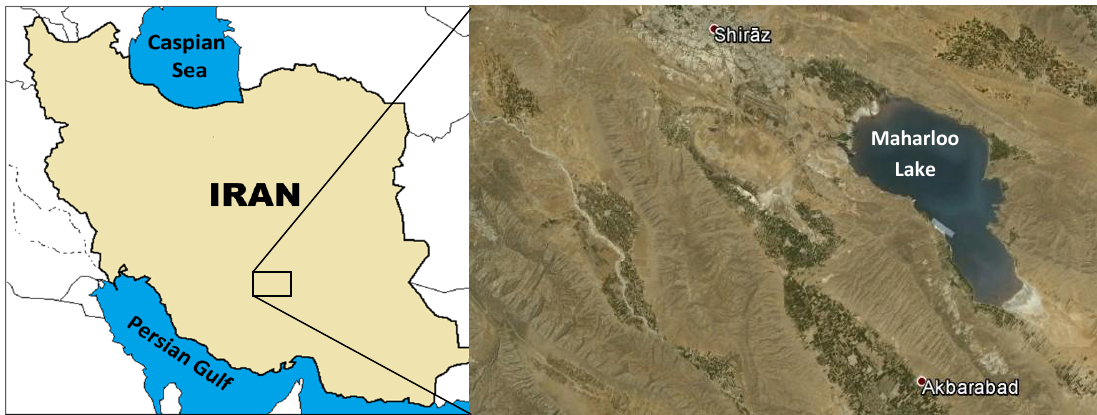
Fig. 1. Satellite image of Maharloo Lake in the southern Iran. Figure 1. Satellite image of Maharloo Lake in the southern